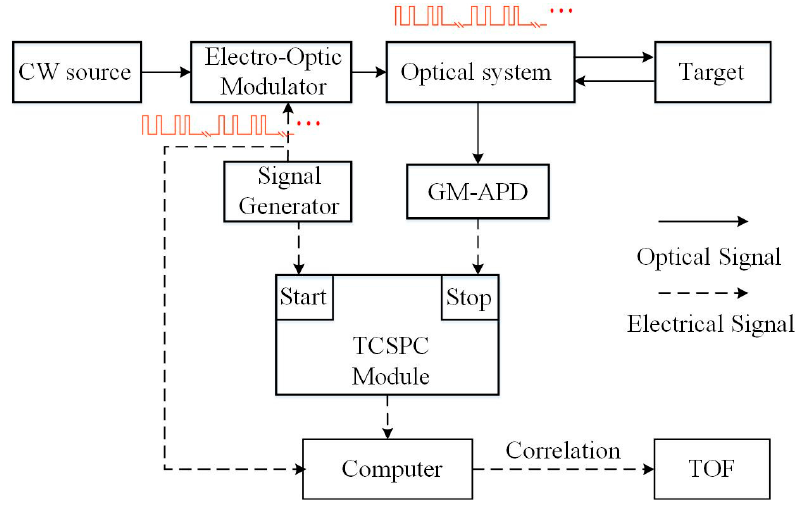
Figure 1. Schematic of pseudo-random ranging system.